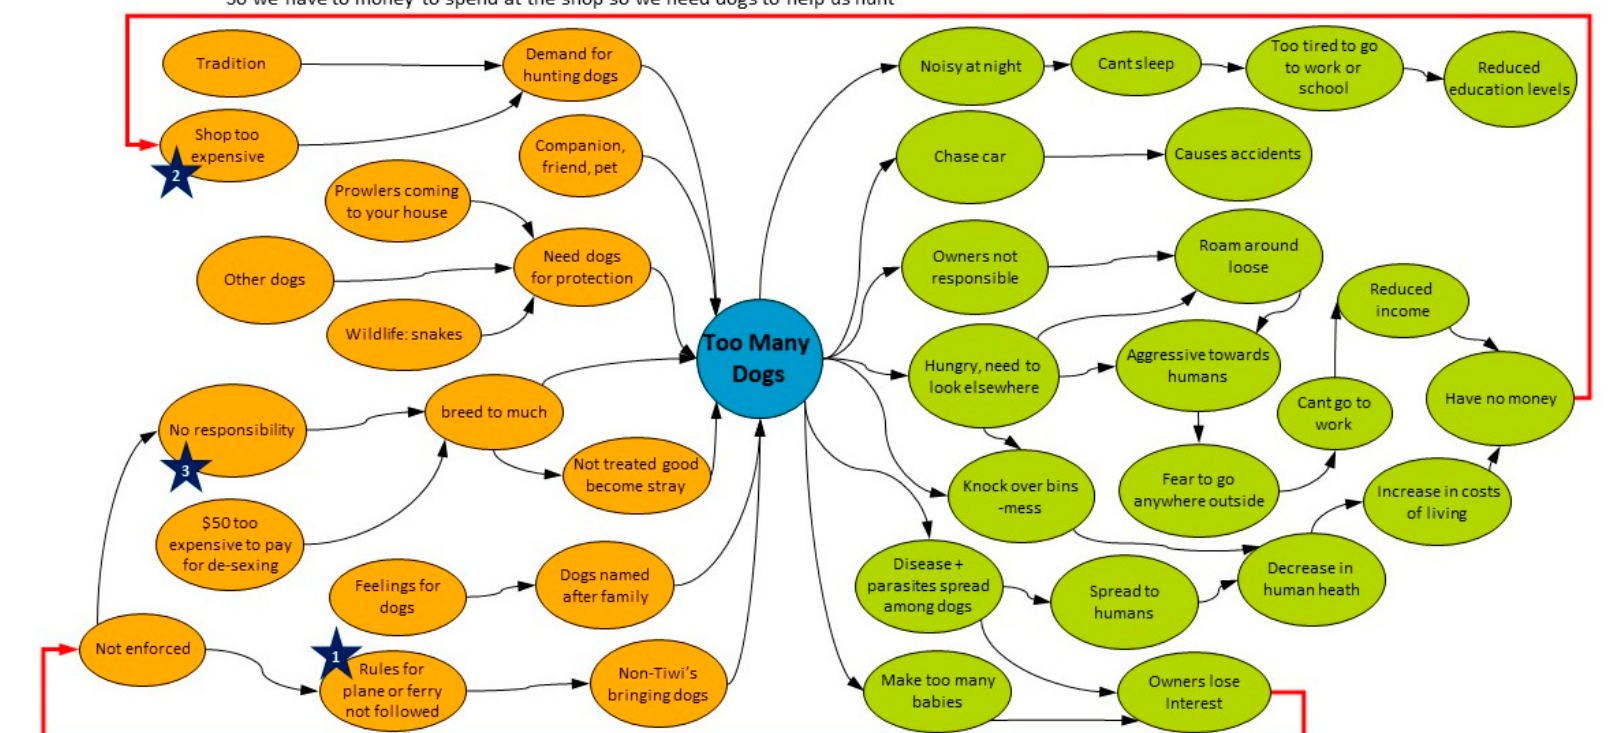
Figure A1. Causal Loop Analysis (CLA) of ‘too many dogs’ conducted during Focus Group Discussions (FGDs) with Indigenous Locals (ILs) of Wurrumiyanga. The first seven CLA’s conducted in FGDs with ILs are presented in ( a – g ), the eighth CLA with ILs, and the single CLA by IR, and AM groups can be found in the main text.